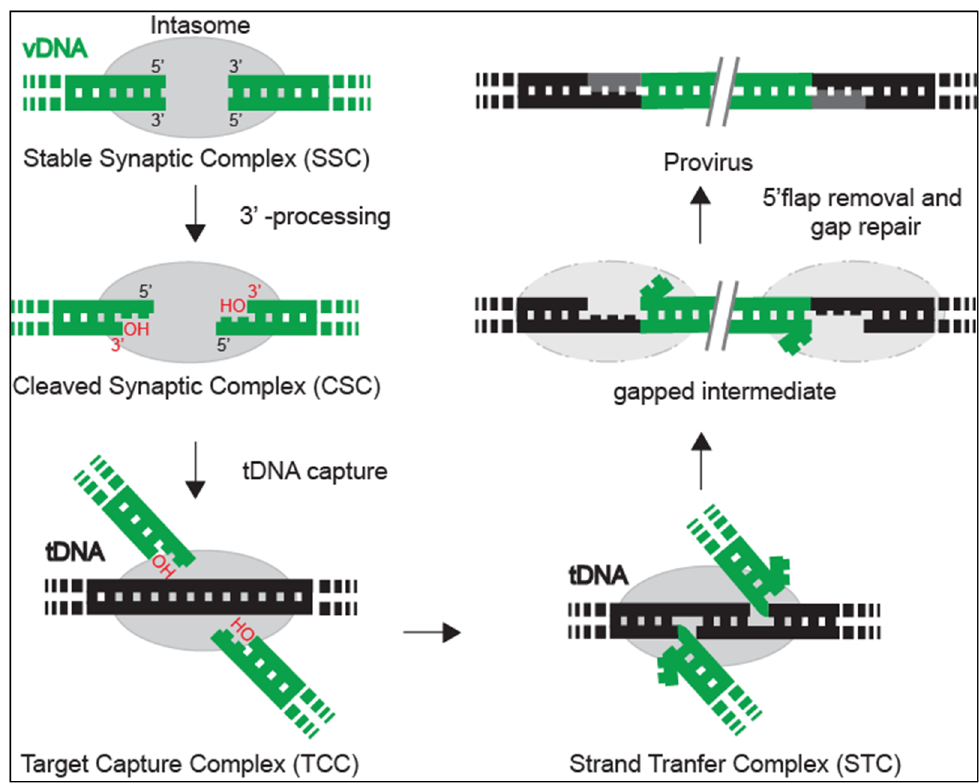
Figure 1. Integrase catalytic functions and intasome complexes. The integration process starts when IN (depicted by grey oval) associates with two ends of vDNA (in green), establishing a stable synaptic complex (SSC), which is the first intermediate of the integration reaction pathway. Then, IN cleaves two nucleotides at each 3 ′ end of vDNA, forming the cleaved synaptic complex (CSC). Then, the tDNA (in black) is captured to form the target capture complex (TCC), and the integration occurs within the strand transfer complex (STC). Once the STC disassembles, the two flapping nucleotides from 5 ′ are removed, and the gapped intermediate is repaired by cellular enzymes to fill the single strand connection between vDNA and tDNA of the resulting provirus [12].